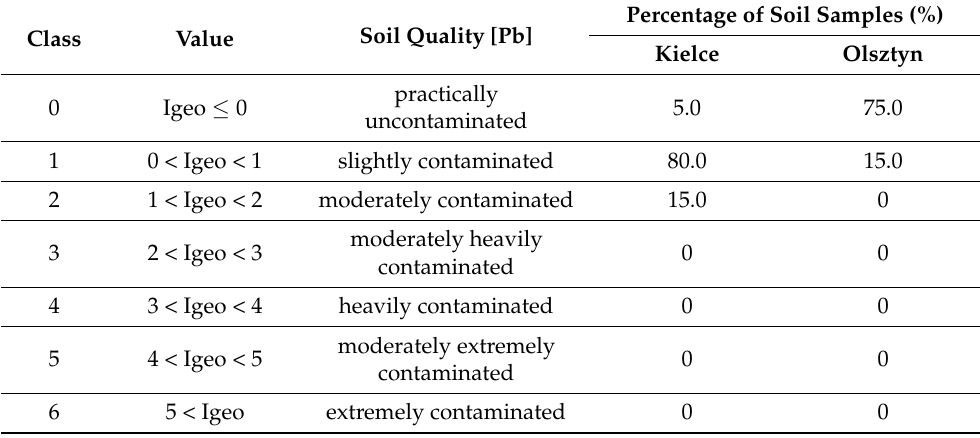
Table 6. Classification of soil quality according to the assumptions of geoaccumulation index for lead. Percentage of Soil Samples (%) Class Value Soil Quality [Pb] Kielce Olsztyn practically 5.0 75.0 0 Igeo ≤ 0 uncontaminated 1 0 < Igeo < 1 slightly contaminated 80.0 15.0 moderately contaminated